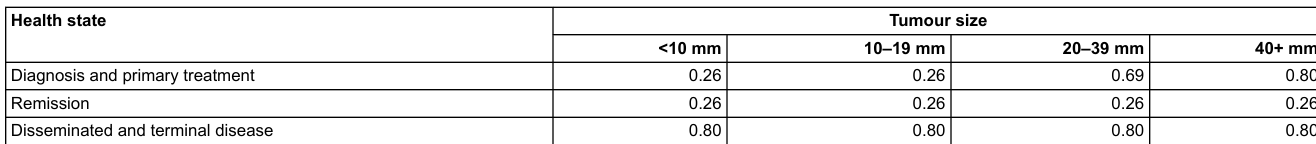
Table 3: One-year trastuzumab drug cost.